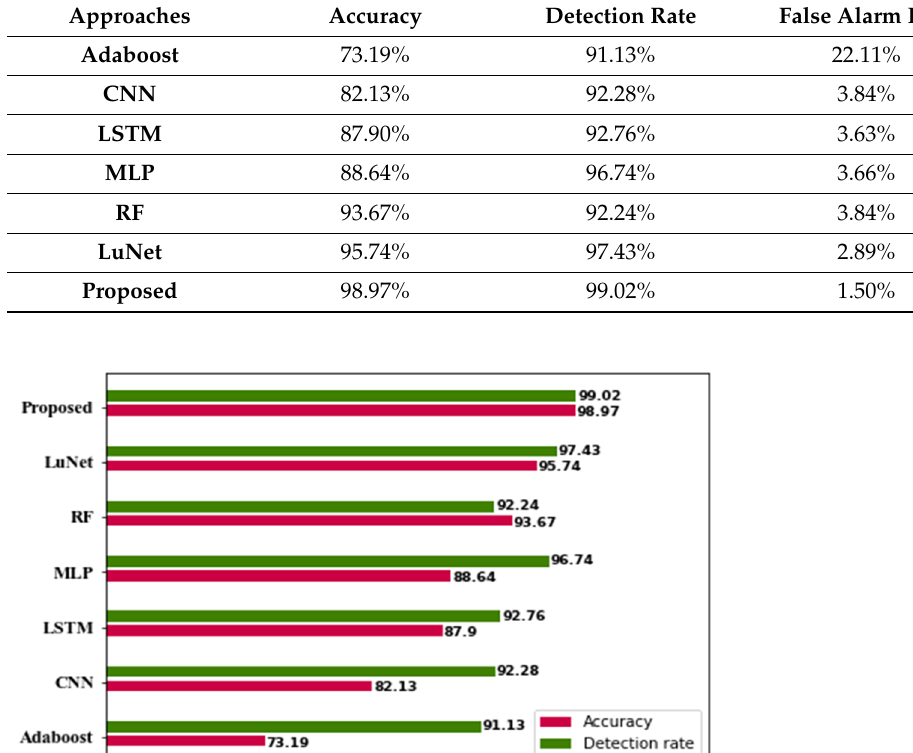
Table 11. Differentiation of the proposed approach with various existing approaches.